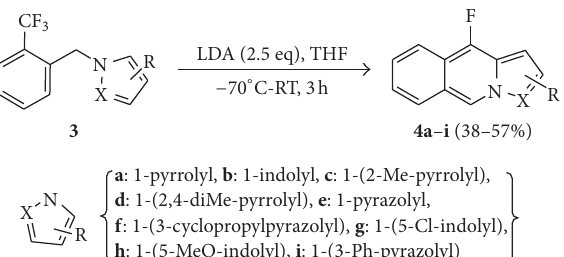
Figure 1: Isoquinoline ring assembly